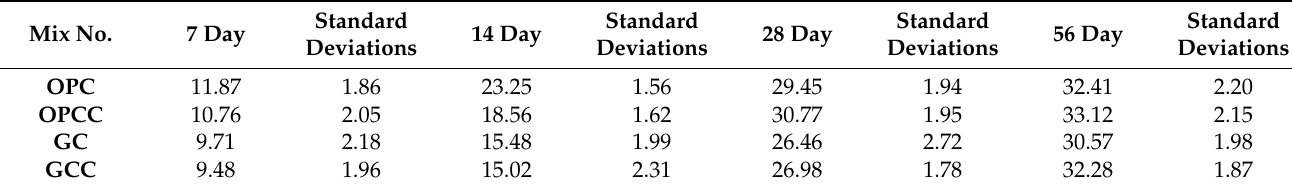
Figure 5. Compressive strength development curves. Table 14. The detailed data of the compression strength.